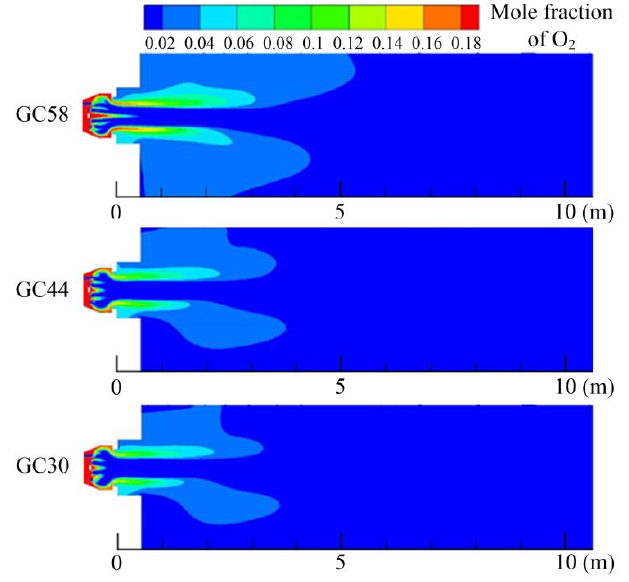
Figure 9. The distribution of Mole fraction of O 2 for GC58, GC44 and GC30 at z = 0.